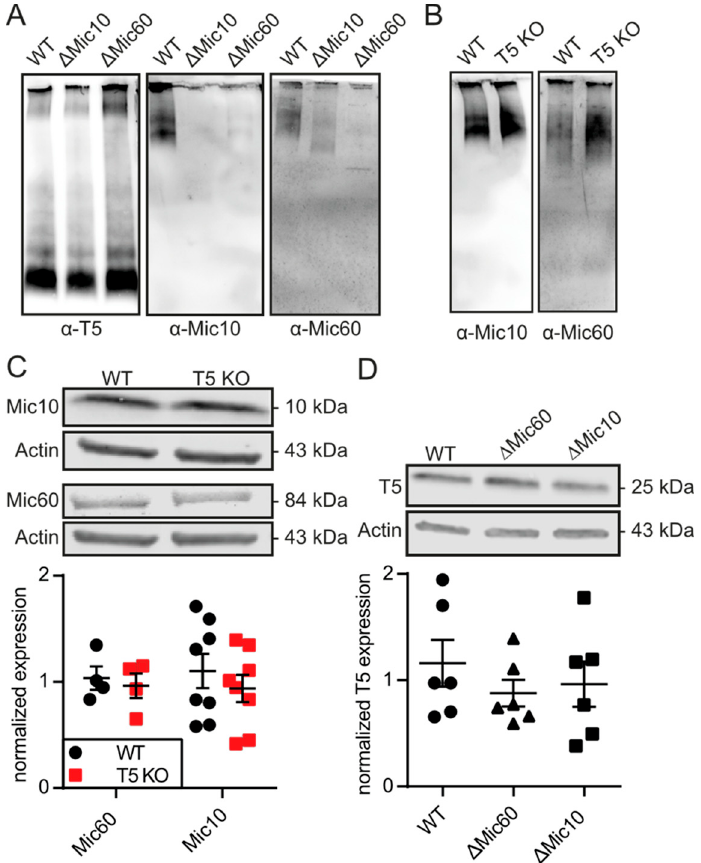
Figure 4. TMBIM5 is not part of the same macromolecular complex as mitochondrial contact site and cristae organizing system (MICOS) proteins Mic10 and Mic60 and does not affect their abundance. ( A ) Blue native PAGE stained for TMBIM5/Mic10/Mic60 as central proteins of the MICOS complex in WT HEK293 cells or in HEK293 cells with a knockdown of either Mic10 or Mic60. ( B ) Blue native PAGE stained for Mic10/Mic60 in HAP1 cells WT/TMBIM5-KO. ( C ) Western blot and quantification of protein expression of Mic60/Mic10 in HAP1 cells WT/TMBIM5-KO. ( D ) Western blot and quantification of TMBIM5 expression in HEK293 cells WT/ Δ Mic60/ Δ Mic10. Each data point represents one immunoblot. Mean ± SD is indicated.